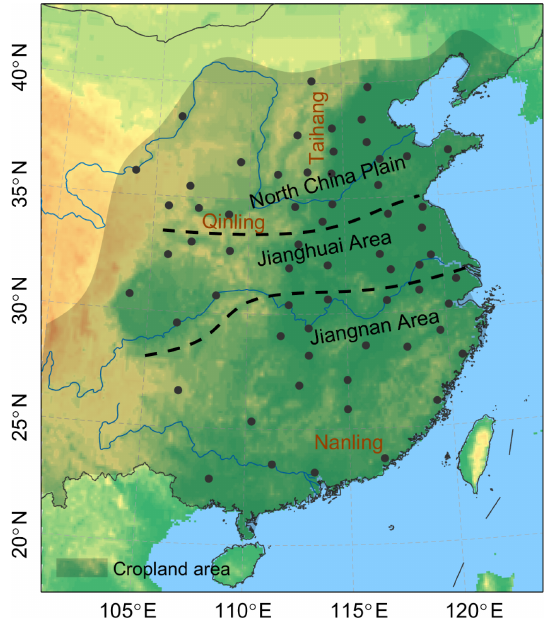
Figure 1. Locations of 63 drought/flood grade data stations and subregion divisions. The shaded area indicates approximate crop- land distributed from 801 to 1910,